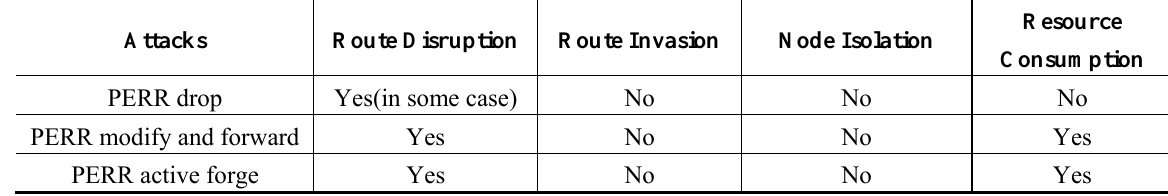
Table 6. Misuse of PERR messages and achievable misuse